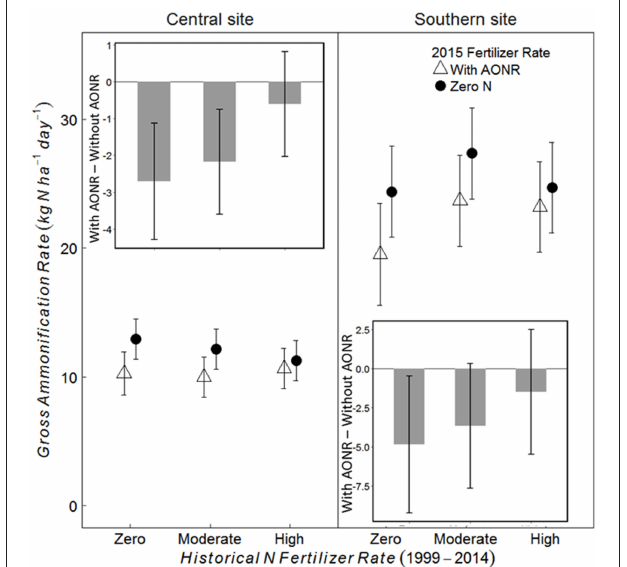
FIGURE 6 | Gross ammonification rate (kg N ha − 1 day − 1 ) and the difference (inset) between the gross ammonification rate (kg N ha − 1 day − 1 ) with and without agronomic optimum N rate (AONR) application in 2015 in three historical N rate treatments (zero, moderate, and high) at the V5 maize growth stage at central and southern Iowa sites. Individual plots received the same N rate every year 1999–2014. In 2015, the historical N rate plots were split and received either zero N or the empirically determined long-term agronomic optimum N rate (AONR). Vertical bars represent 95% confidence intervals.